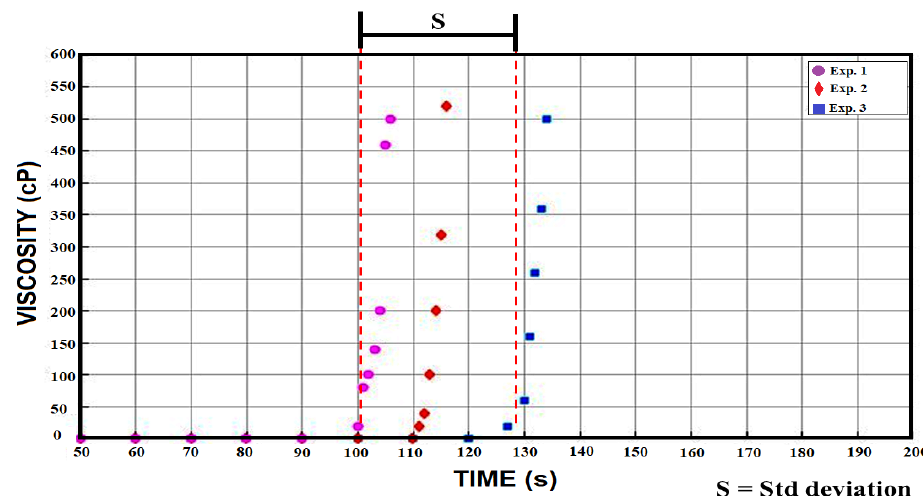
Figure 8. Three experiments of the H-3 formulation are represented in the figure above. Once the 60 cP barrier is exceeded, the viscosity rises exponentially. After a few minutes the photopolymerization is finished and the hydrogel is formed.